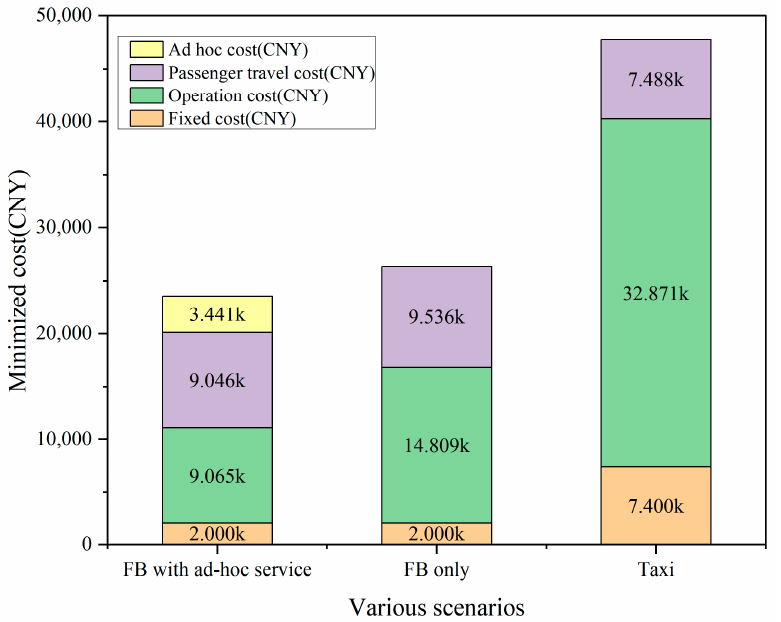
Figure 5. Results of FB only.